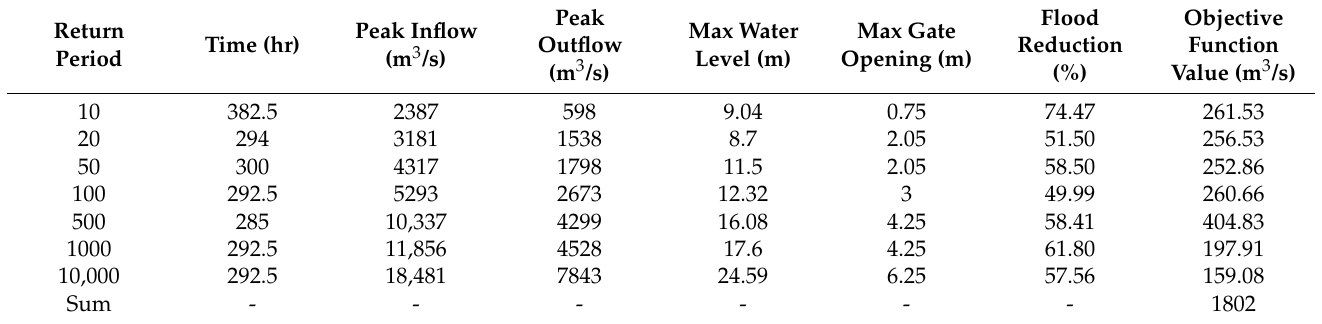
Table 9. Optimized results from simulated optimization model OP2 (genes, 100; population, 80; n =